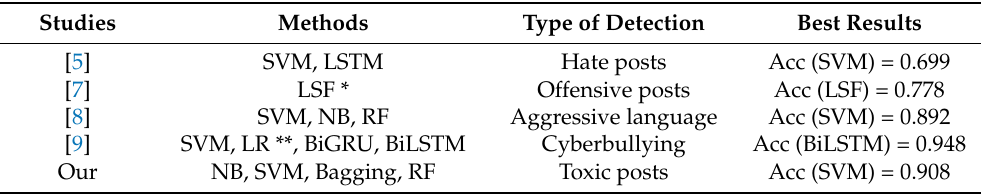
Table 12. Comparison of results in Accuracy of our best model to the best models from previous studies focused on the same respectively similar problem.